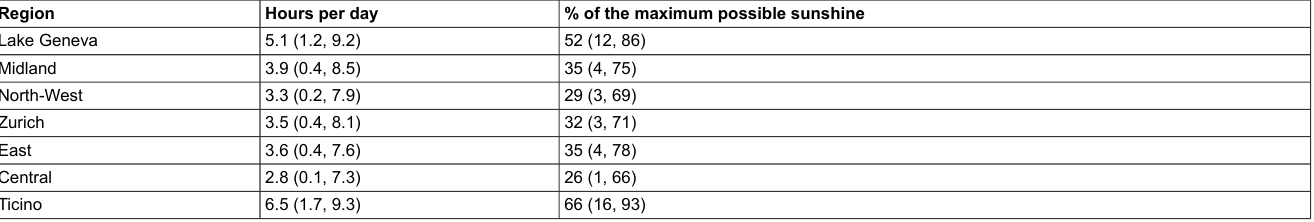
Table S2: Summary statistics of sunshine data in the seven major regions of Switzerland.